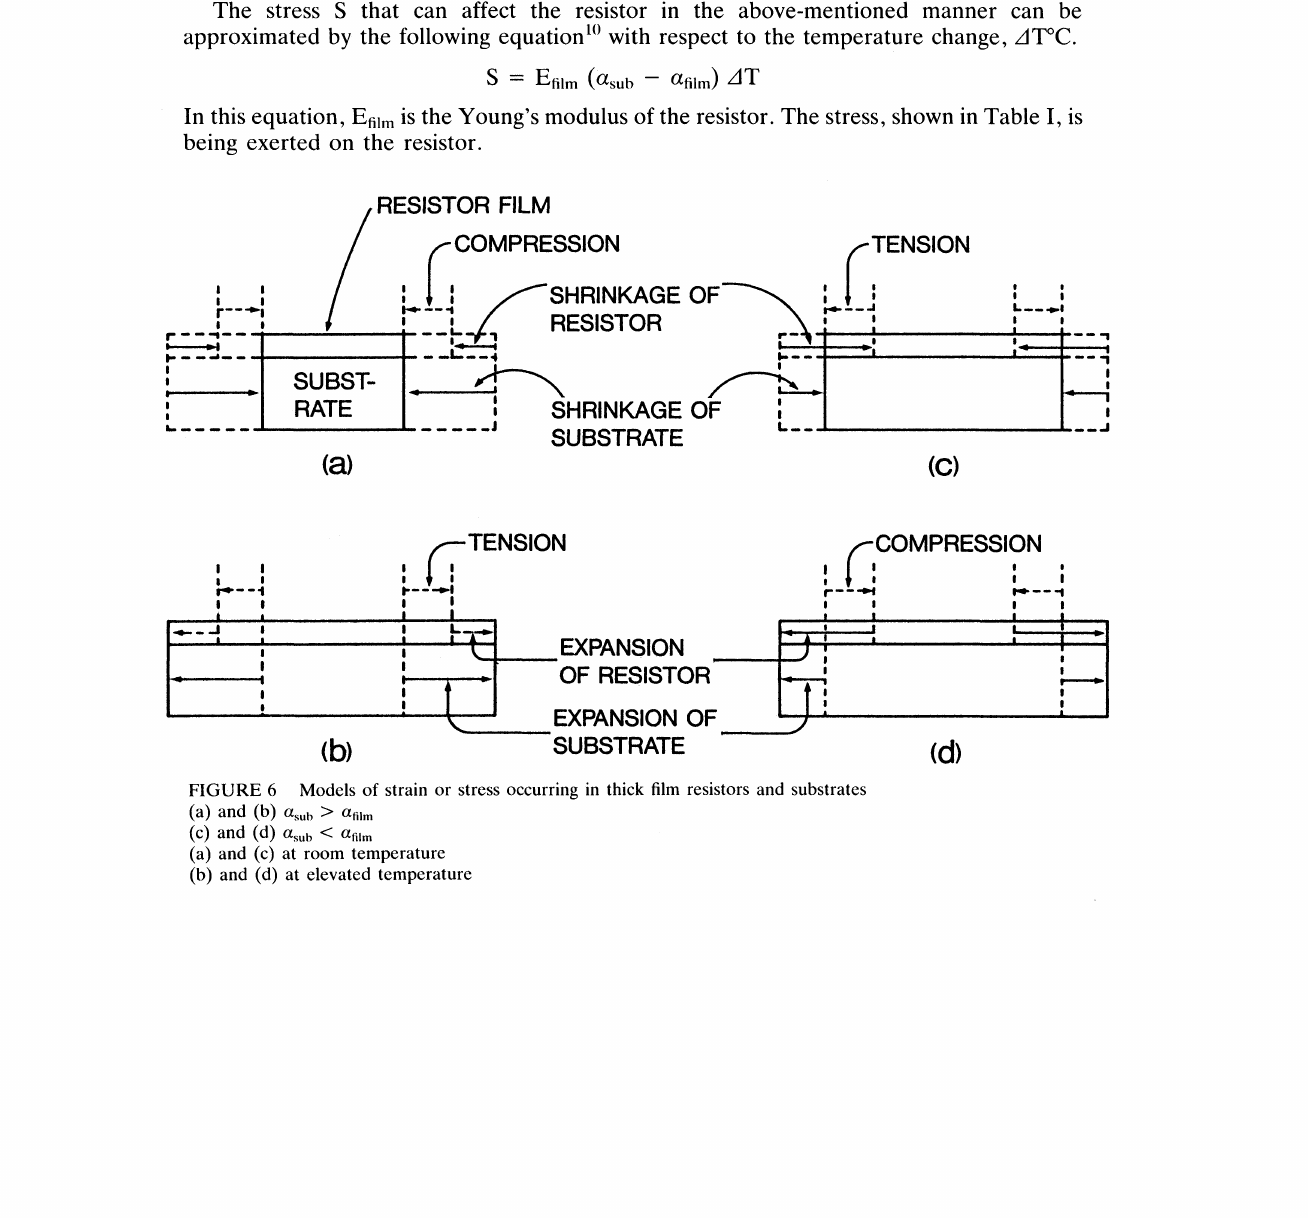
FIGURE 6 Models of strain or stress occurring in thick film resistors and substrates (a) and (b) asub > fiim (c) and (d) asub < film (a) and (c) at room temperature (b) and (d) at elevated